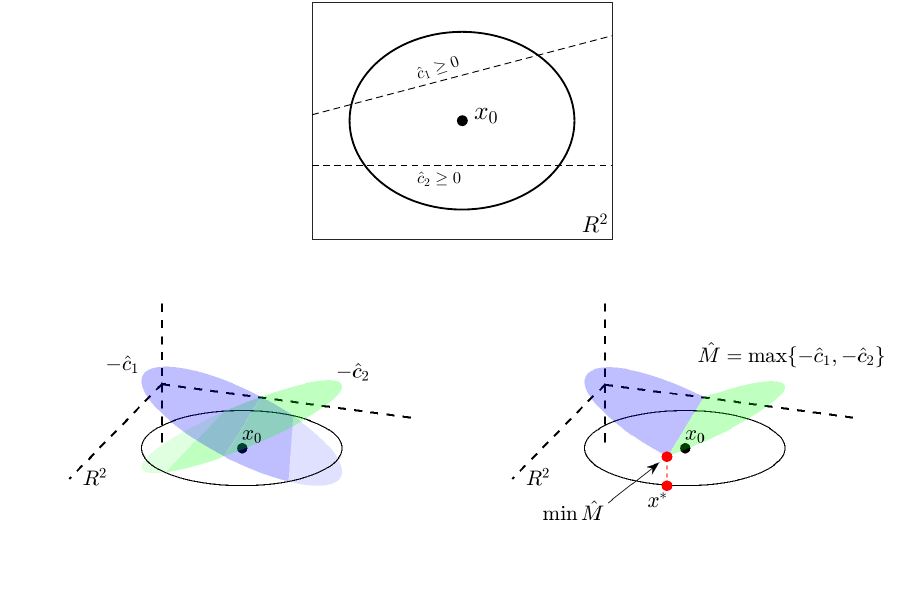
Figure A4. Minimization of ˆ M Should the constraints ˆ c i ( x ) ≥ 0 be inconsistent with one another within the trust region || x − x 0 || 2 ≤ ρ , the candidate vertex x ∗ is chosen to minimize ˆ M : = max {− ˆ c i ( x ) : i = 1, . . . , m } . (top) The constraints ˆ c 1 ( x ) ≥ 0 and ˆ c 2 ( x ) ≥ 0 are inconsistent within the region || x − x || ≤ ρ . (bottom left) Graphs of the affine functions − ˆ c 0 2 right) The vertex x ∗ is defined to be the point within the trust region (black circle) at which ˆ M is